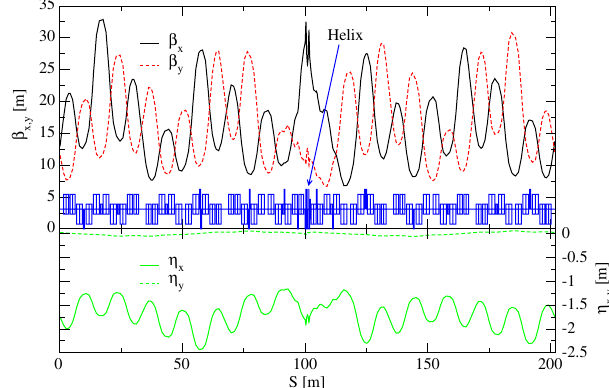
FIG. 10. The beta ( (cid:1) x;y ) and eta ( (cid:2) x;y ) functions over three superperiods of the AGS with four helices and the placement of the compensation quadrupoles as shown in Table III. In each three superperiod section of the AGS a helix of strength 1.9 T is placed at the middle of the three superperiods of the AGS. The strengths of the horizontal and vertical tune quadrupoles and those of the compensation quadrupoles are set to match the optical and dispersion function among each of the four sections of the AGS. The corresponding betatron tunes for this beam optics appear in the 4th row of Table II.